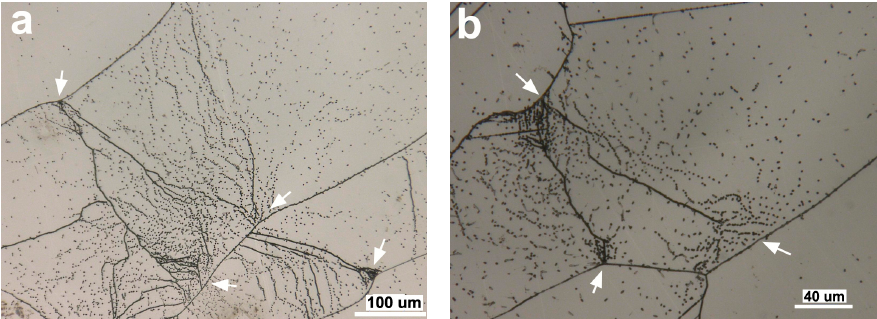
Figure 4. Image of grains with dislocations emanating from grain boundaries: ( a ) with four regions, and ( b ) with three regions.